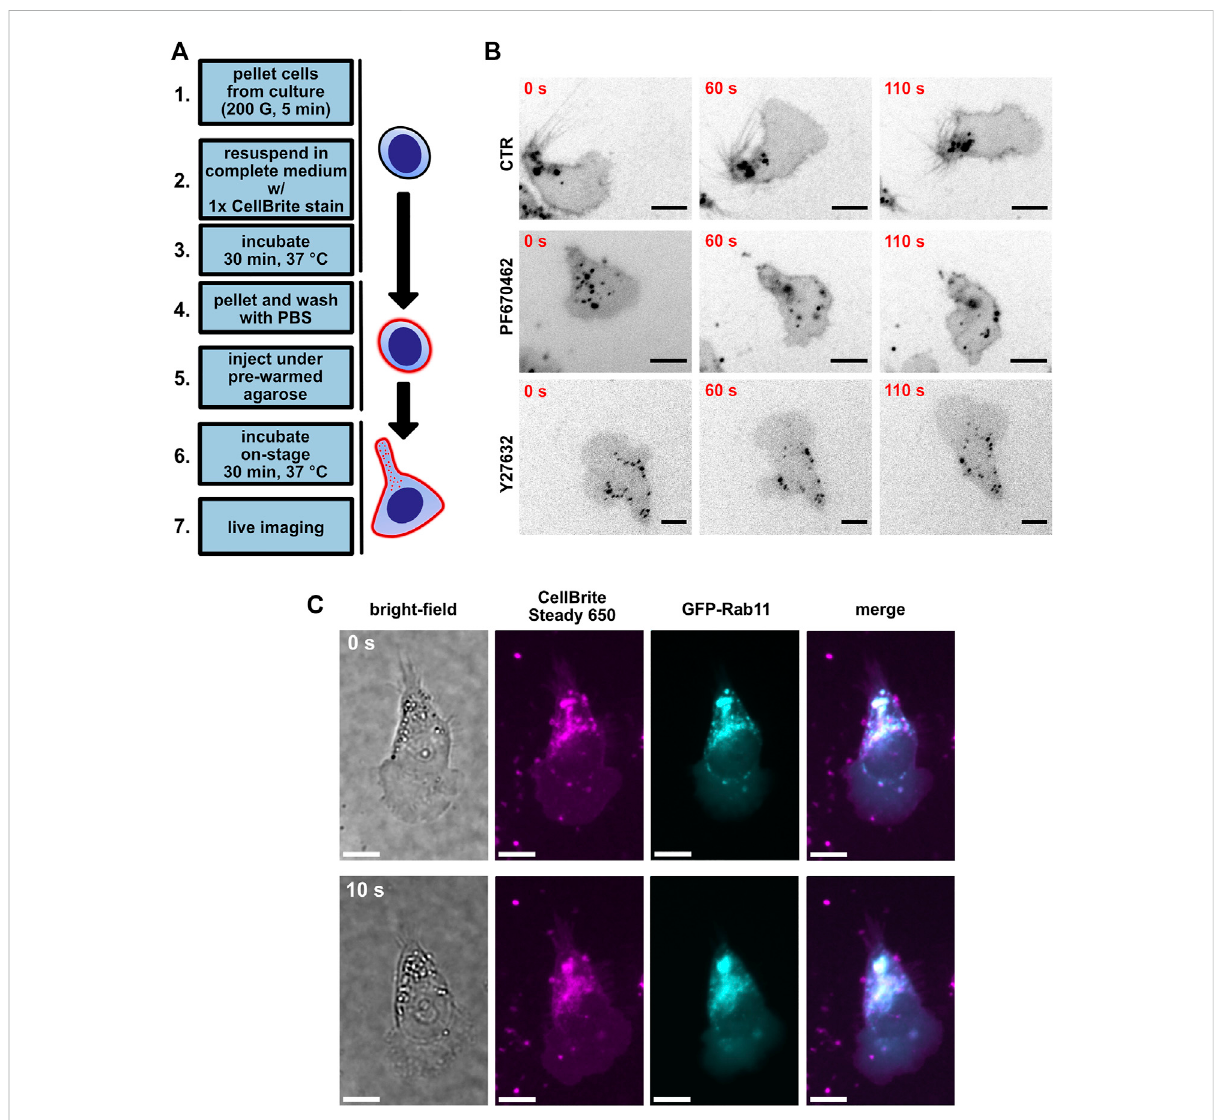
FIGURE 4 Visualizationofuropodendocyticpolarity usingtheCellBrite plasmamembranestain. (A) Aschemeoftheprotocolusedforplasmamembrane staining. (B) MEC-1cellsstainedwithCellBriteSteady650plasmamembranestain(black);scalebar:10 µm.Shownarethreetimepointsfromatime- lapseexperiment.Upperlane:controlconditiontreatedwithDMSO.Middle:MEC-1cellstreatedwith10 µMPF670462.Bottom:MEC-1cellstreated with10 µMY27632. (C) RepresentativeimageofGFP-Rab11overexpressionexperimentinMEC-1cells. Shownaretwotimepointsfromatime- lapse experiment. Magenta: CellBrite Steady 650. Cyan: GFP-Rab11. Scale bar: 10